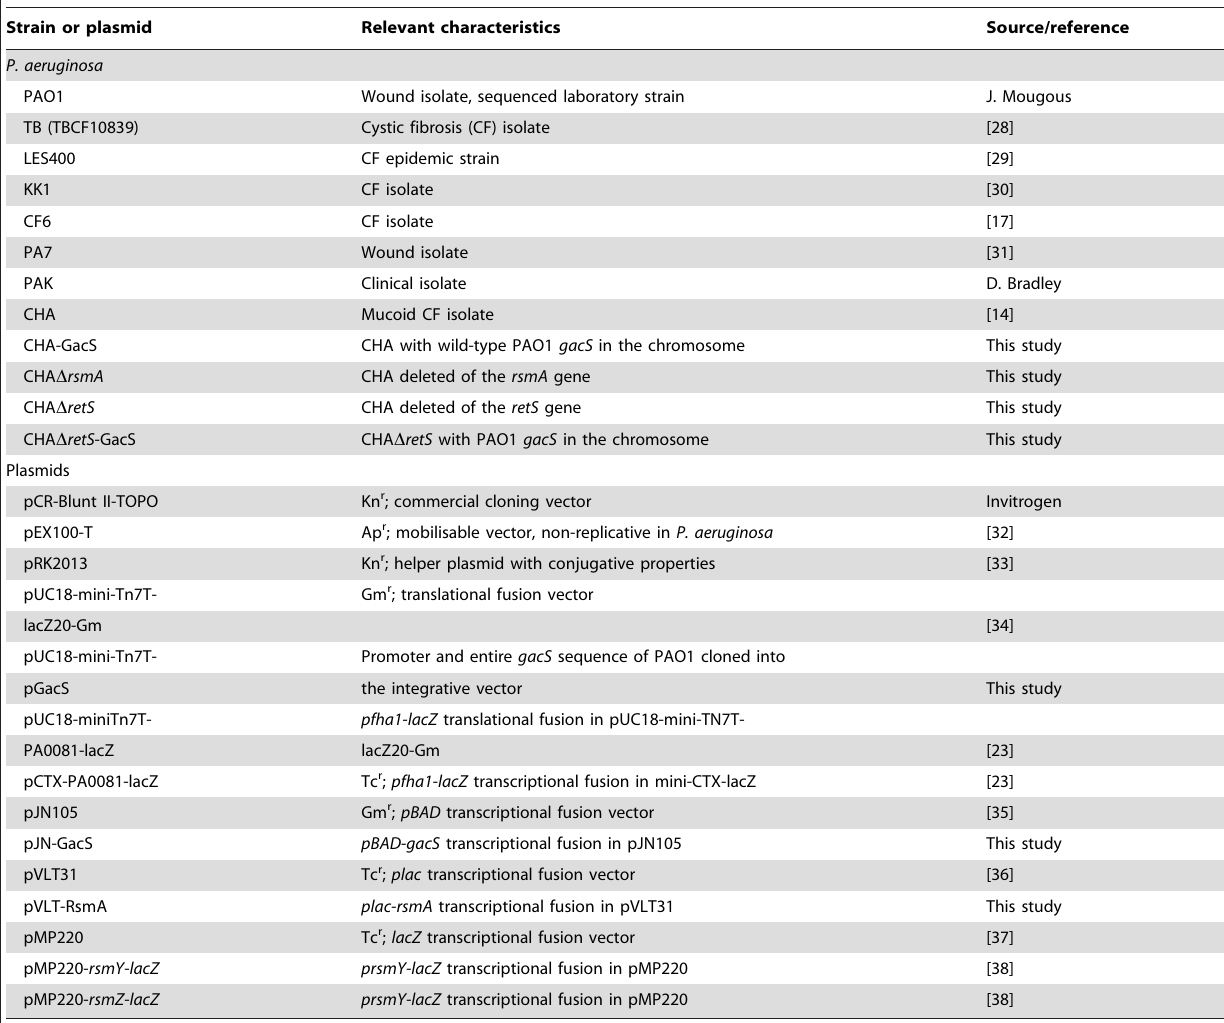
Table 1. Bacterial strains and plasmids used in this